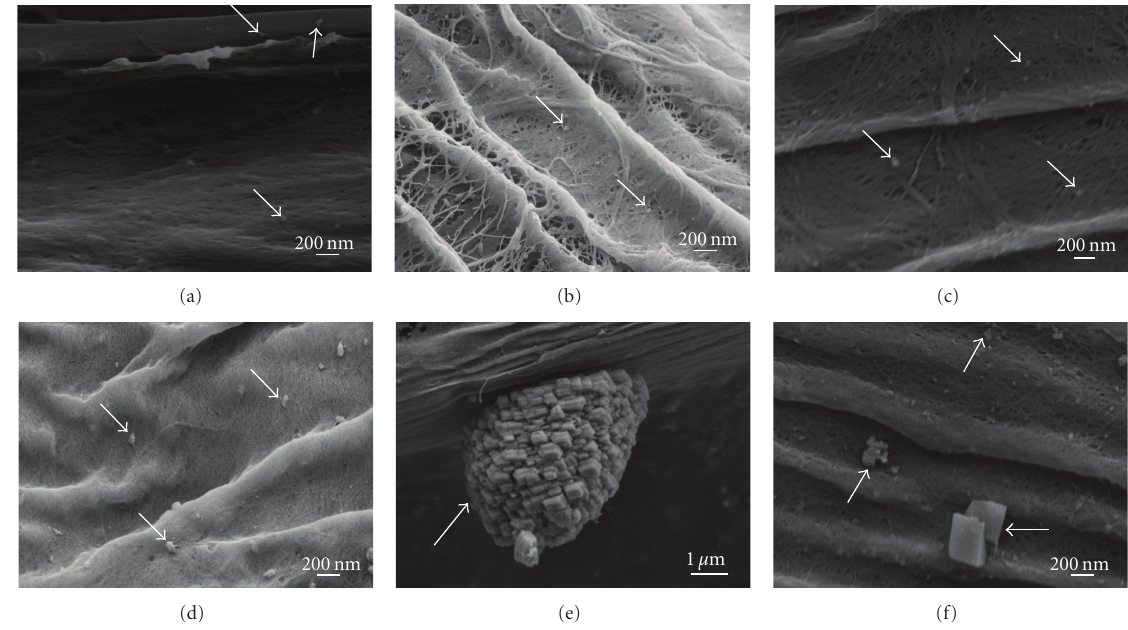
Figure 2: SEM images of INI-treated fibers. (a) 100 ◦ C (Na 2 CO 3 :CaCl 2 = 1:1, mol:mol), (b) 100 ◦ C (Na 2 CO 3 :CaCl 2 = 1 :2, mol:mol), (c) 130 ◦ C (Na 2 CO 3 :CaCl 2 = 1:1, mol:mol), (d) 130 ◦ C (Na 2 CO 3 : CaCl 2 = 1: 2, mol:mol) at 1:2, (e) 160 ◦ C (Na 2 CO 3 : CaCl 2 = 1: 1, mol:mol), and (f) 160 ◦ C (Na 2 CO 3 :CaCl 2 = 1:2, mol:mol). The white arrows designated the CaCO 3 particles.